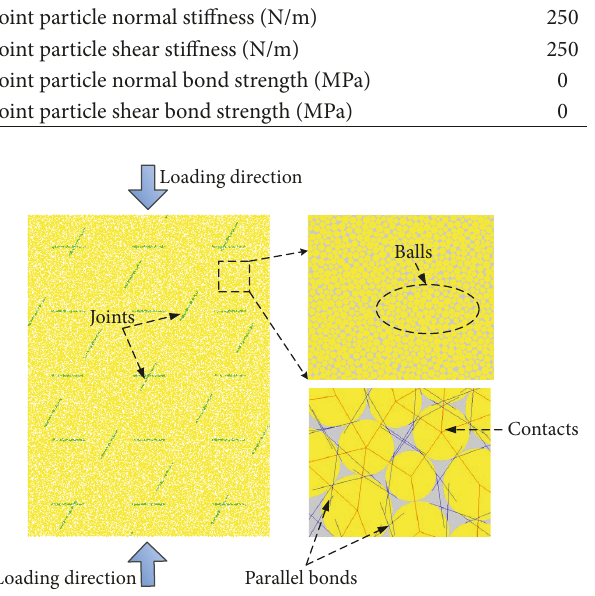
Figure 5: Numerical intact specimen generated in PFC2D in this research